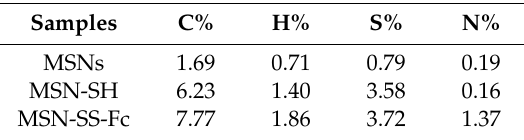
Table 1. Elemental analysis data for MSNs, MSN-SH, and MSN-SS-Fc. Samples